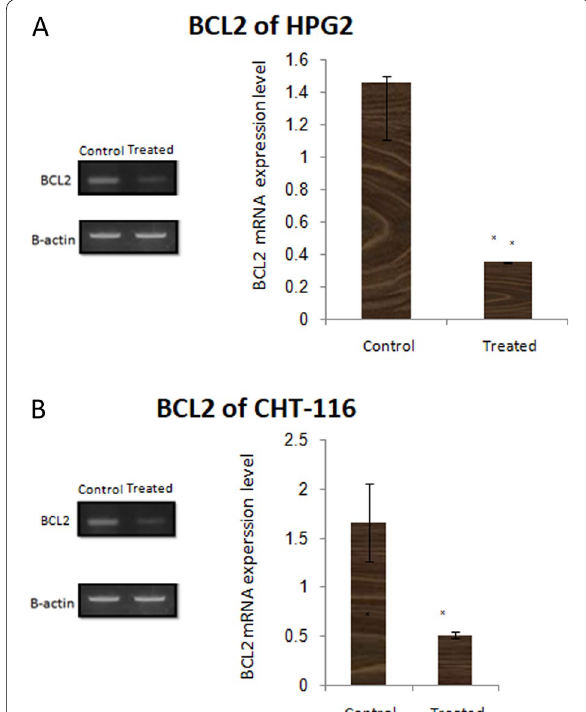
Fig. 6 PCR detected the expression of BCL2 in HepG2 and HCT‑116 cells after treatment with NSP where the internal control expressed by the β‑actin gene. In each illustrative experiment data represent means SE performed in triplicate. *represents significantly dissimilar ± results (P <